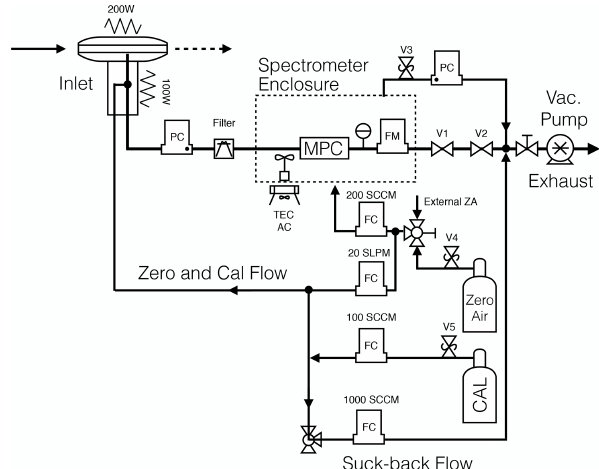
Figure 4. Flow system diagram. V1-2: flow control valve; V3-5: pressure relief valve; PC: pressure controller; FC: flow controller; FM: flowmeter; MPC: multi-pass cell; CAL: calibration gas cylin- der; TEC AC: thermoelectric air conditioner; filter: 3µm particle